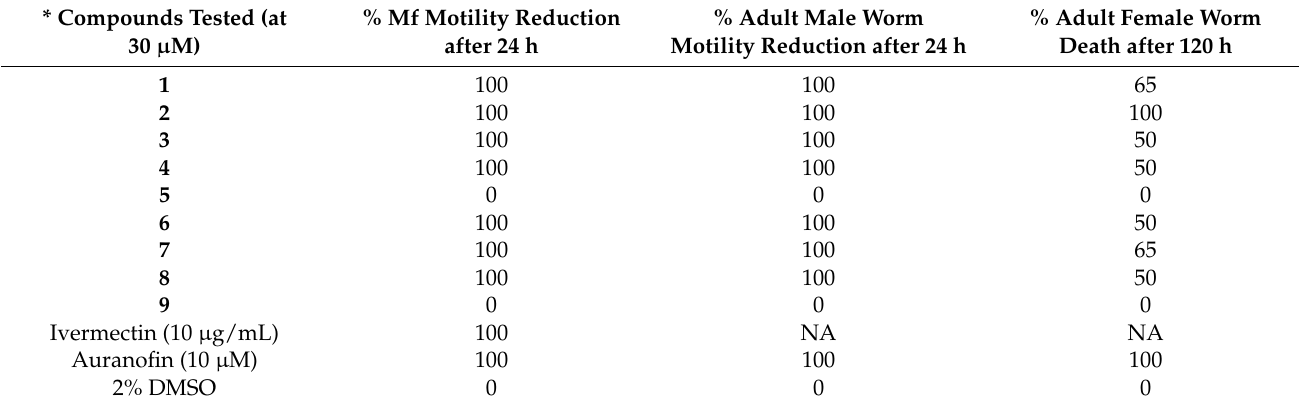
Table 2. Effect of isolated compounds on O. ochengi worms in primary screens.